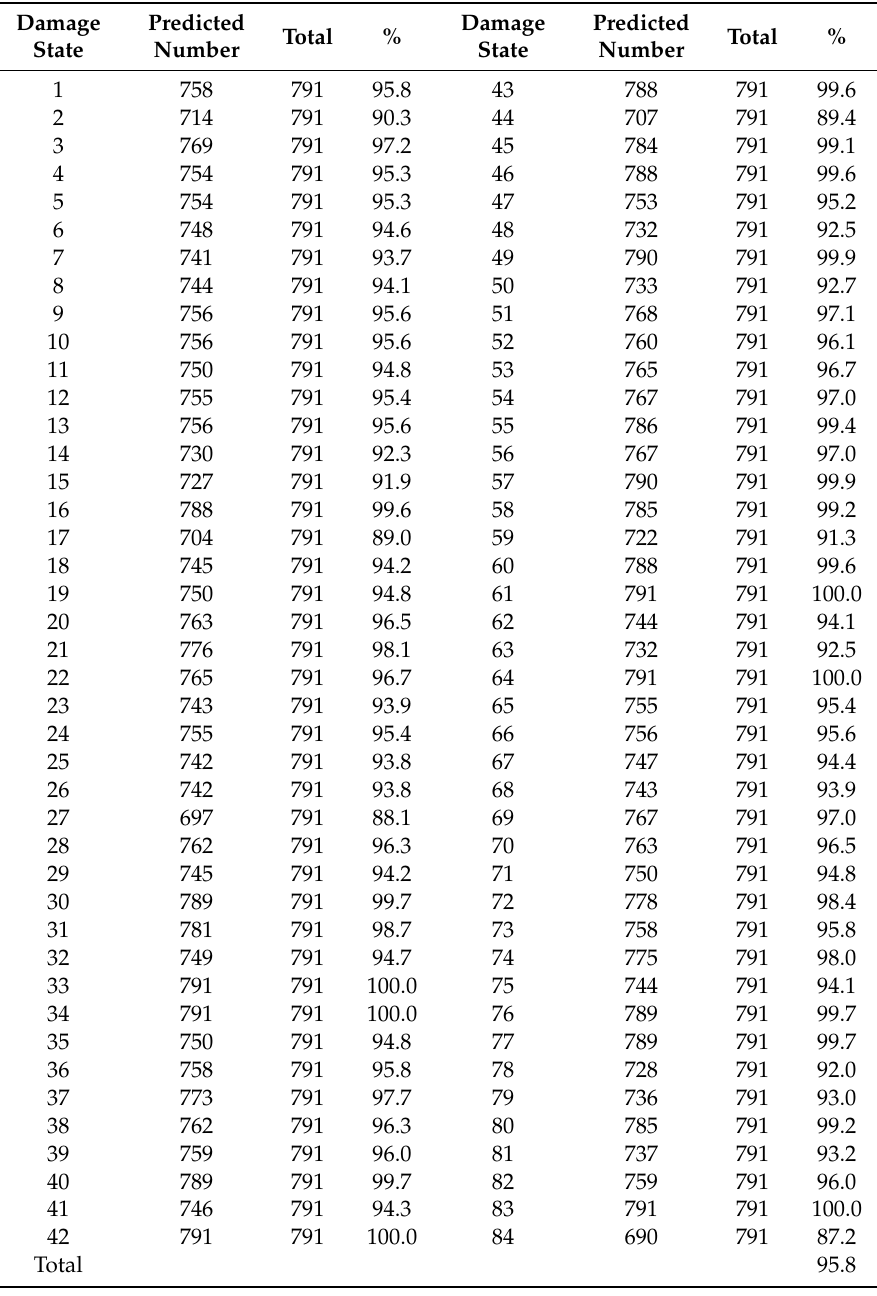
Table 7. Detection results of dataset